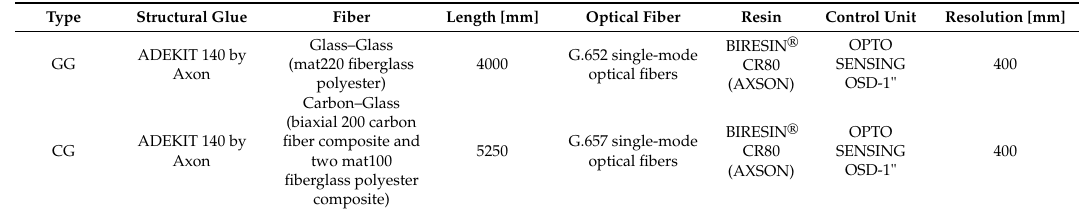
Table 6. Third test: specimen parameters.